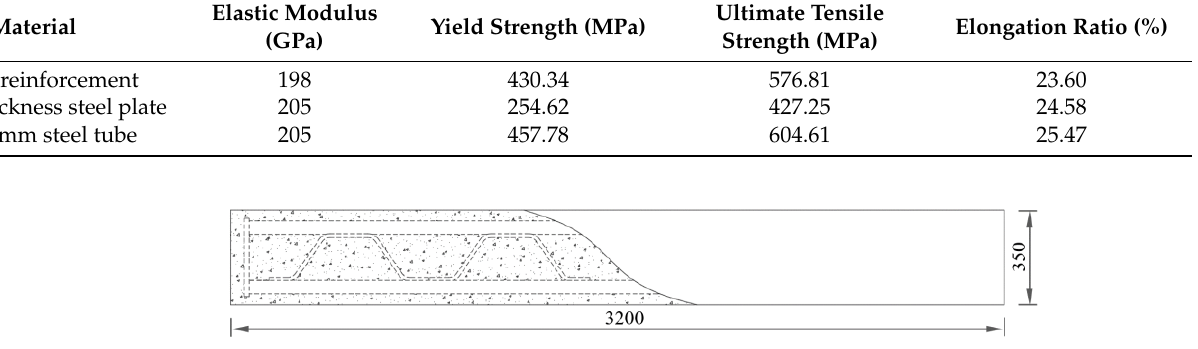
Figure 2. The schematic diagram of spatial reticulated grid concrete components.